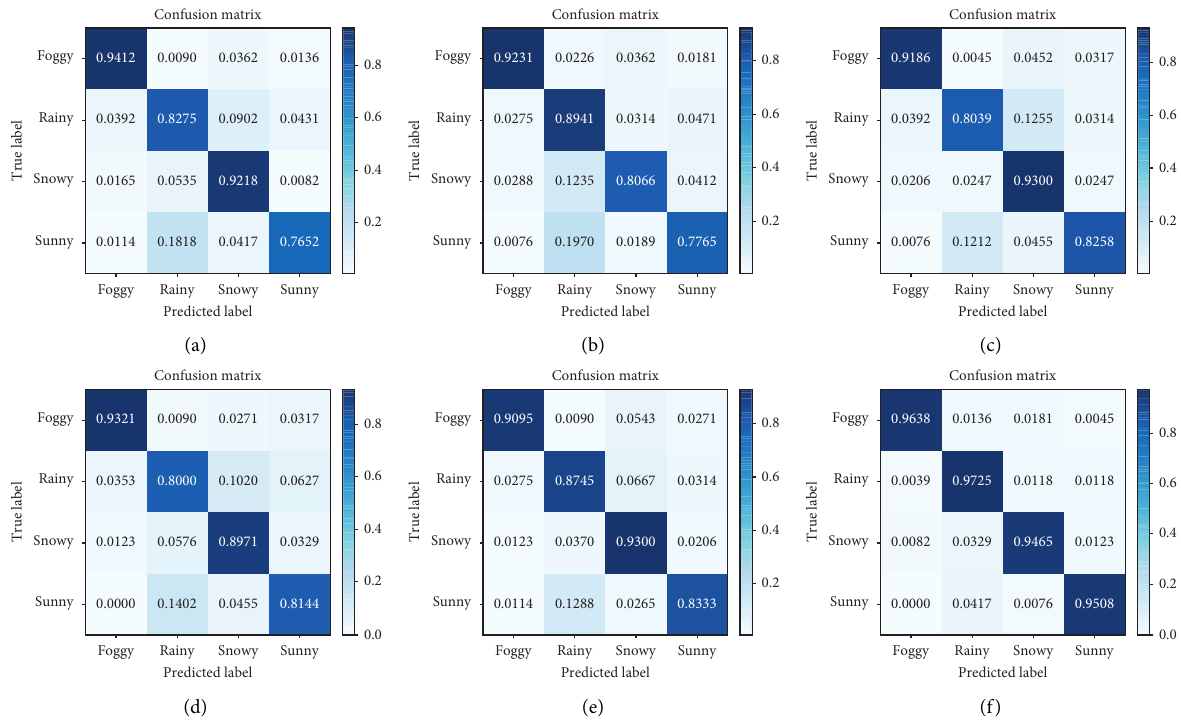
Figure 7: Confusion matrices of different methods. (a) AlexNet. (b) VGG16. (c) GoogLeNet. (d) ResNet50. (e) ResNet34. (f) ResNet15.